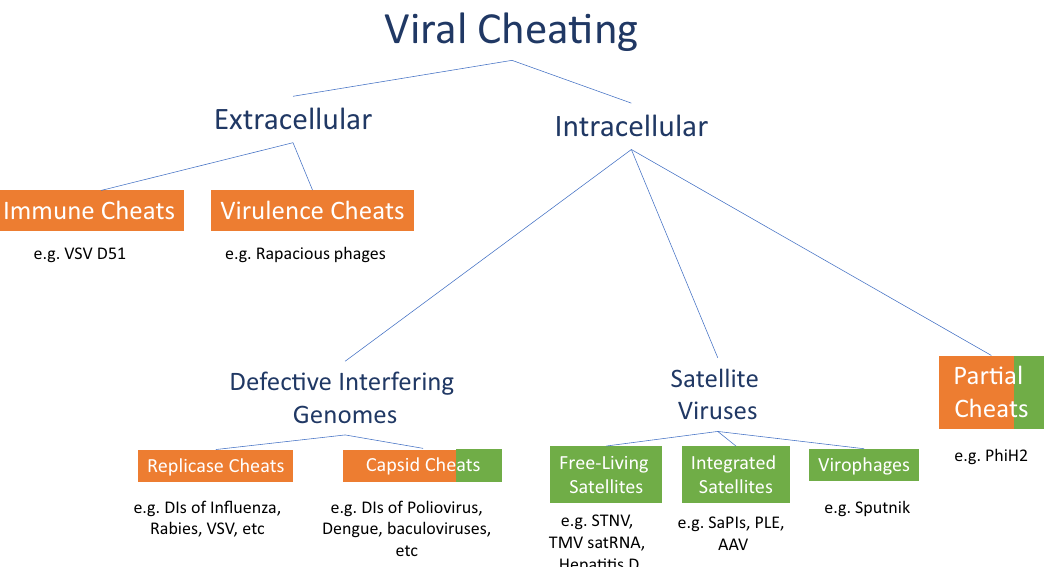
Fig. 4 A classi fi cation of viral cheats. A variety of different kinds of viral entities are cheats. We fi rst divide viral cheats depending on whether the cooperation that is being exploited is intracellular or extracellular, then according to their origins, and fi nally, the speci fi c gene products exploited, if known. We also denote the evolutionary timescales at which cheats exist. We divide between short-sighted cheats (in orange), which arise and spread within hosts, but not between hosts, and long-sighted cheats (in green), which spread both within and between hosts, and consequently persist over longer evolutionary timescales. We offer a few illustrative, but not exhaustive, examples of each type of cheat 34,42,44,47,53,62,67 – 69,96,109,147 – 150 .